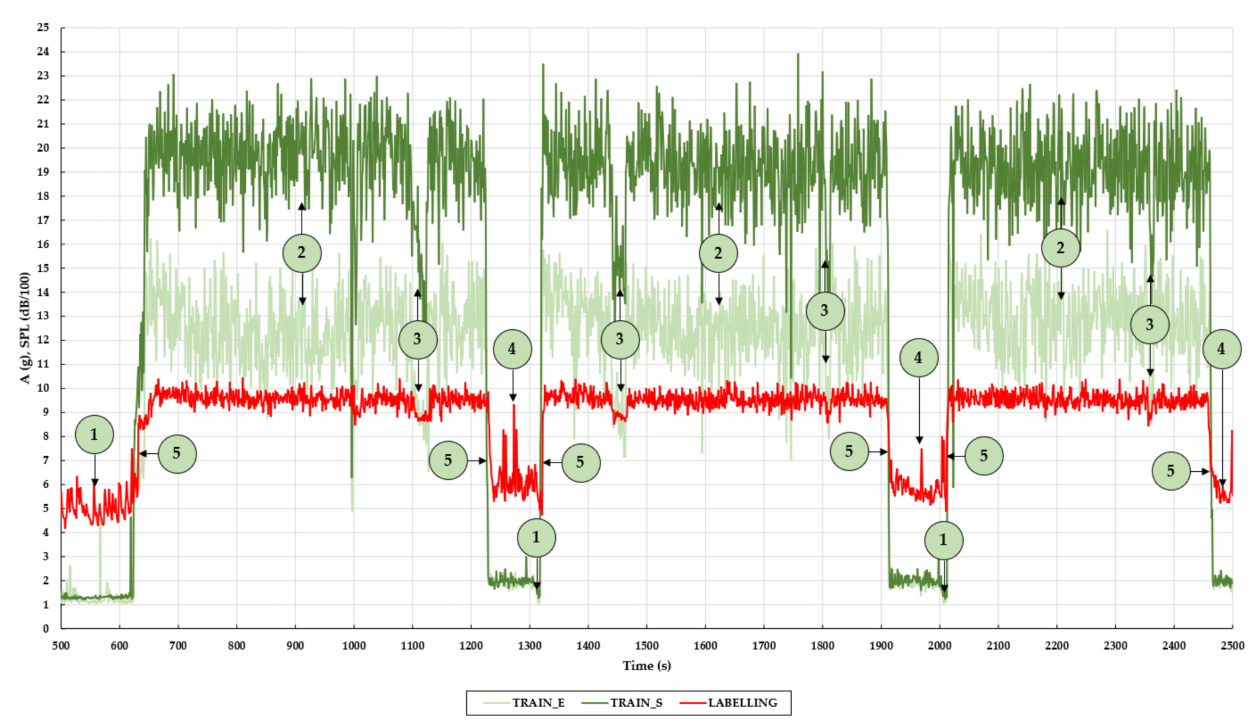
Figure 2. A sample from the acceleration and sound pressure level datasets used jointly to label the data. Note: for convenience, the sound pressure level data was downscaled by a factor of 100 to help in data comparison and labelling tasks. Legend: TRAIN_E stands for the training dataset collected by the placement of acceleration datalogger on the tool’s engine, TRAIN_S stands for the training dataset collected by the placement of acceleration datalogger on the tool’s transmission shaft, LABELLING stands for the sound pressure level data downscaled by a factor of 100; Events: 1—engine off and no movement of the worker (labelled as OFF), 2—engine on and felling (labelled as ON), 3—engine on and not felling (labelled as ON), 4—engine off and movement of the worker (labelled OFF), 5—data segments which were transient (inter-class variability) between the two engine states (labelled as